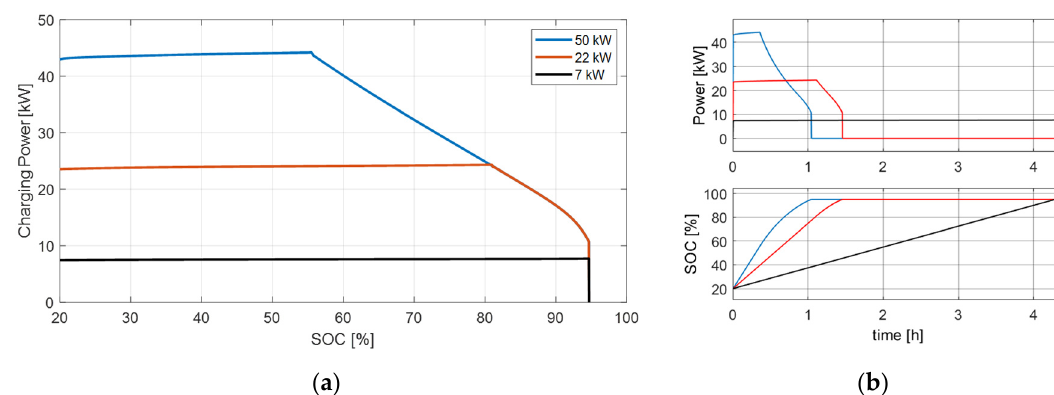
Figure 4. Charging of an EV battery of 40 kWh capacity by using three levels of power: 50, 22, and 7 kW. The charging process starts at state of charge (SOC) = 20% and stops when SOC = 95%: ( a ) shows the relation between the charging power and the SOC value; ( b ) shows the power profile (top) and the SOC value (bottom) as a function of time.